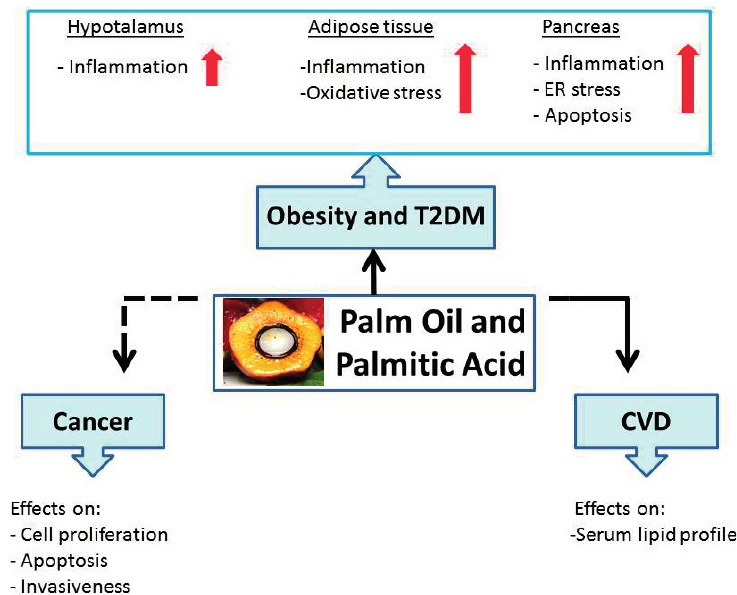
Figure 3. Schematic representation of palm oil and palmitic acid effects on human